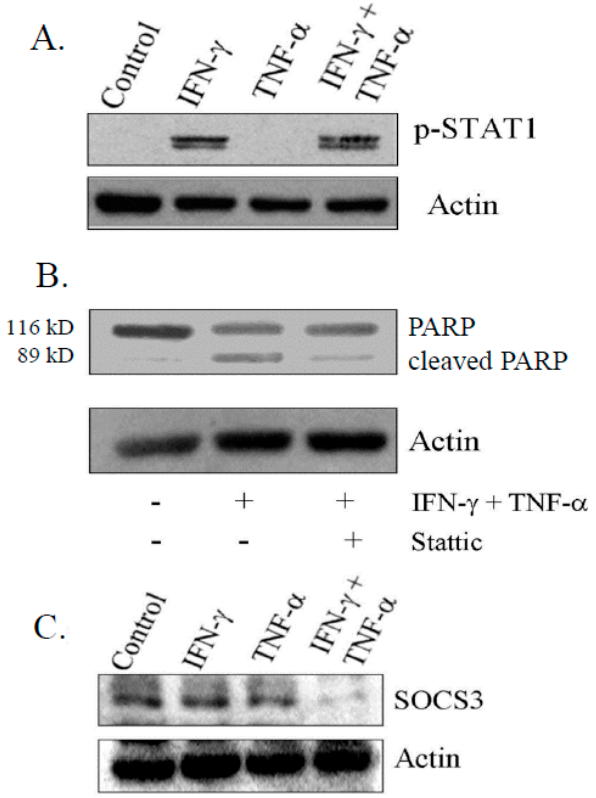
Figure 5. Activation of Signal Transducer and Activator of Transcription-1 (STAT1) on phosphorylation by IFN- γ alone and in combination with TNF- α . ( A ) Activation of phospho-STAT1 (Try-701) in IFN- γ and in combination with TNF- α by immunoblotting; ( B ) Decrease in total PARP in cells treated with STAT1 inhibitor (Stattic) at 2.5 µg/mL; and ( C ) Expression of suppressor of cytokine signaling-3 (SOCS3) on combination treatment for 48 h determined by immunoblotting. − : untreated; +: treated.